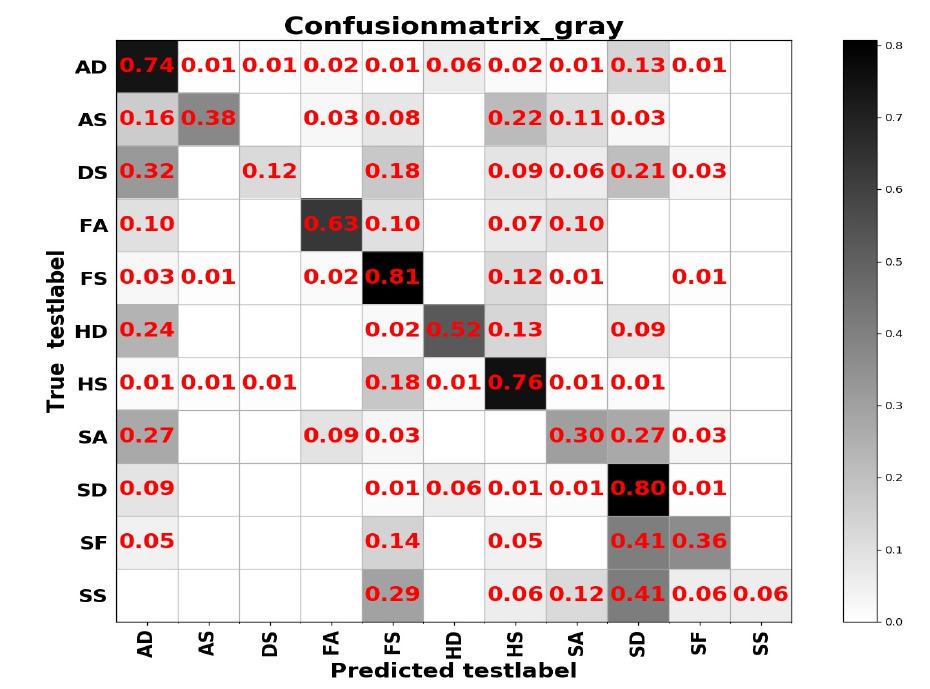
Figure 10. The confusion matrix of the RAF Compound test based on the input channels composed of spatial